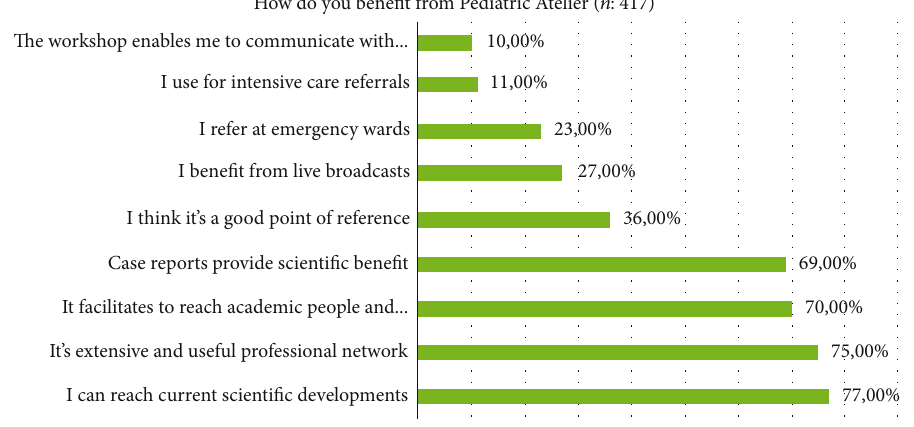
Figure 1: Member ’ s opinions about Pediatric